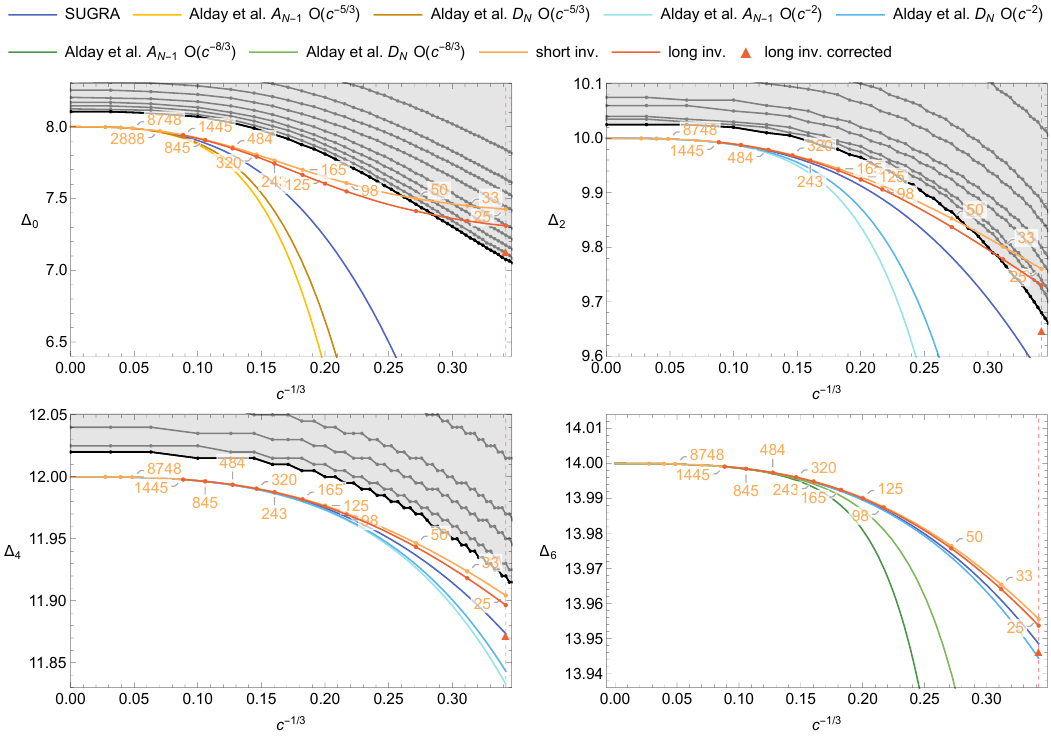
Figure 9. Dimensions of the leading long multiplets with spin 0, 2, 4, 6, against c − 1 / 3 . The gray shaded regions are numerical upper bounds (available for spin 0, 2, 4) from [19]. The orange numbers are central charges (a strict subset of the chosen values correspond to physical theories). The orange curves correspond to short inversions and the red curves correspond to stabilized iterative long inversions up to spin 16 (see text for a detailed explanation). For c = 25 , we also perform a corrected iterative long inversion, taking into account the numerical results of [19], and the result is indicated by a triangular point. We also show 1 /c results from two-derivative supergravity and higher order c α corrections (denoted as O ( c α ) in the plot legend) from [13, 23] whenever available.